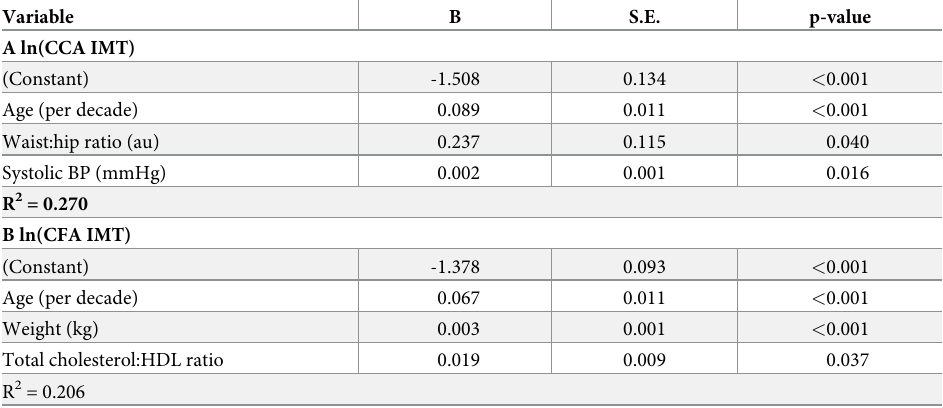
Table 4. Main group IMT base models. The base models for log transformed CCA IMT (A) and CFA IMT (B) show- ing the independent, non-SDB predictor variables for the Main Group.